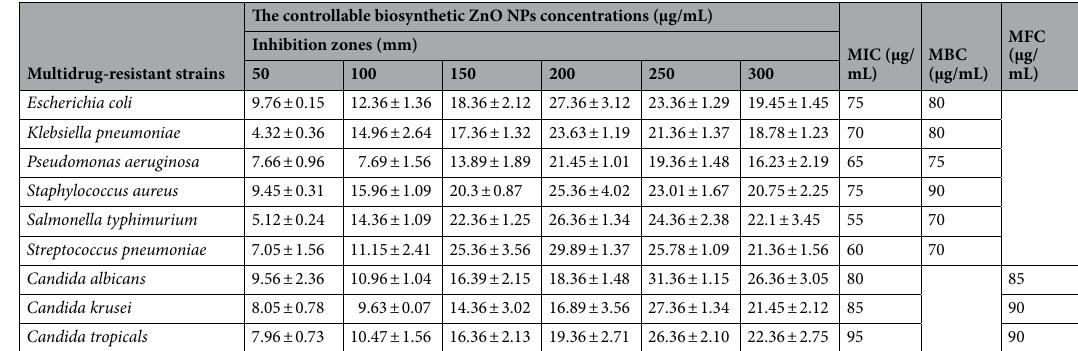
Table 5. The antimicrobial activities of different dosages of the controllable biosynthetic ZnO NPs against some multi-drug resistant human pathogens.